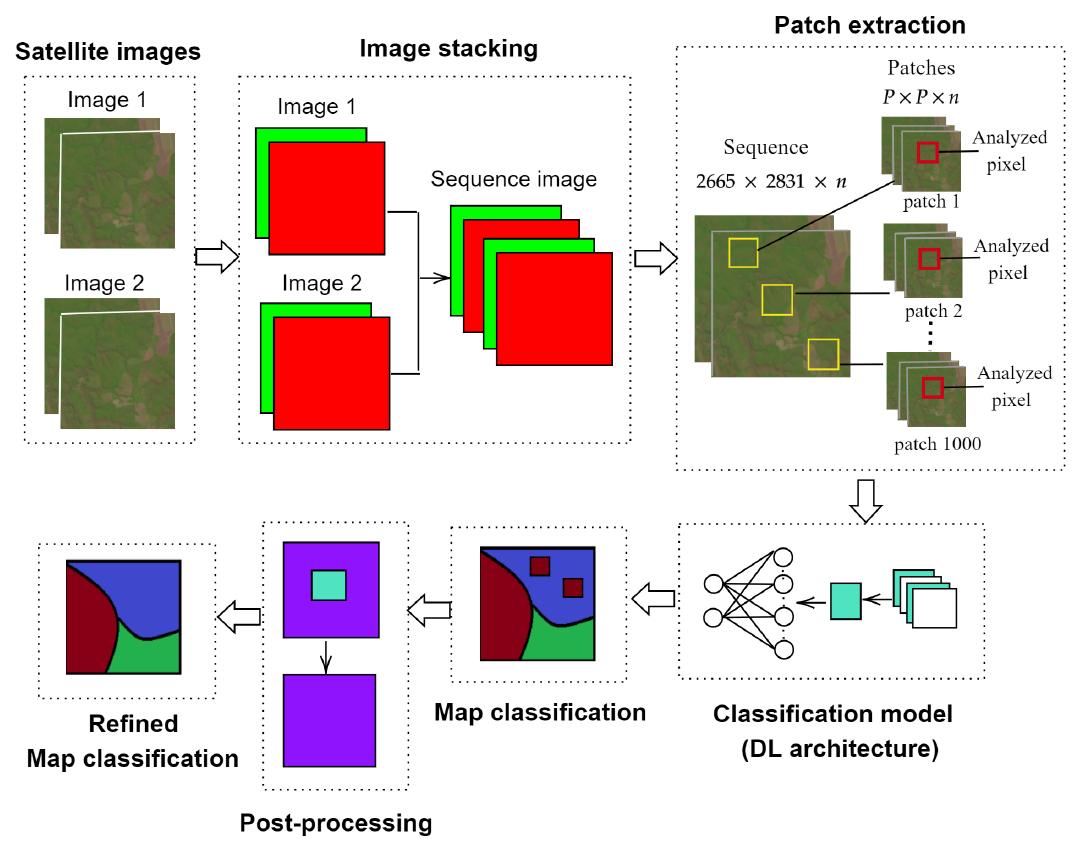
Figure 3. Work-flow of the proposed methodology for crop classification from satellite images. This mainly involves stages for image stacking, patch extraction, classification model, and